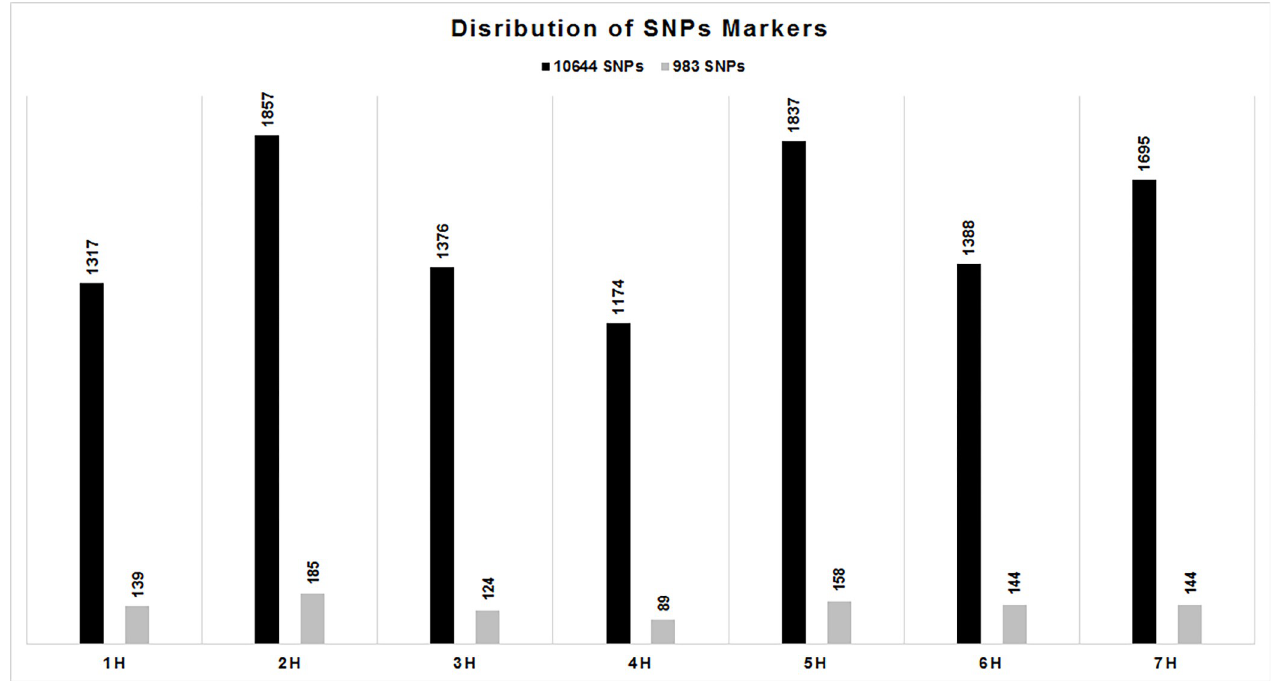
Fig 2. Distribution of filtered (10,644) and highly informative (983) SNPs across the barley